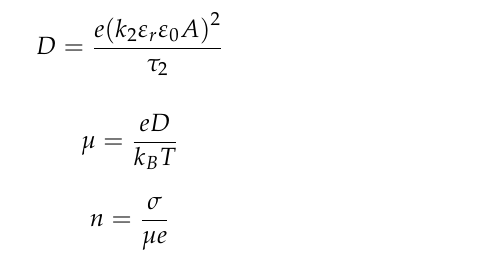
, D , µ , and n for the plasticized samples. 2